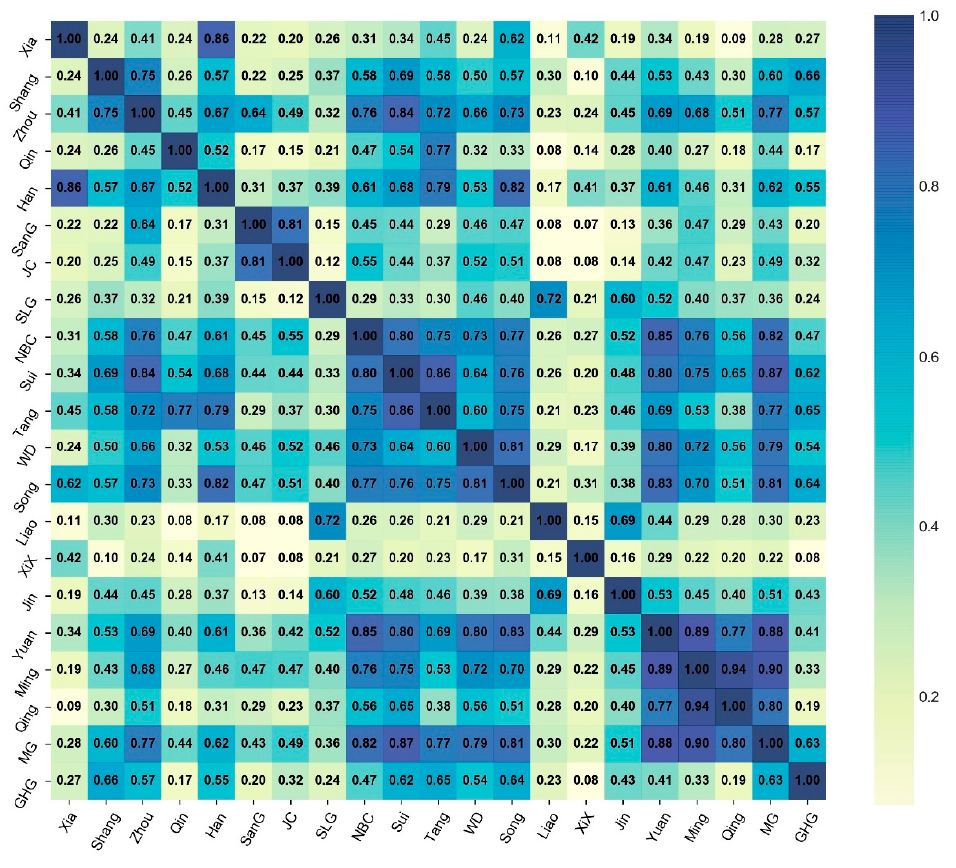
Figure 9. Similarity measurement of the spatial distribution of cultural relics in different dynasties.